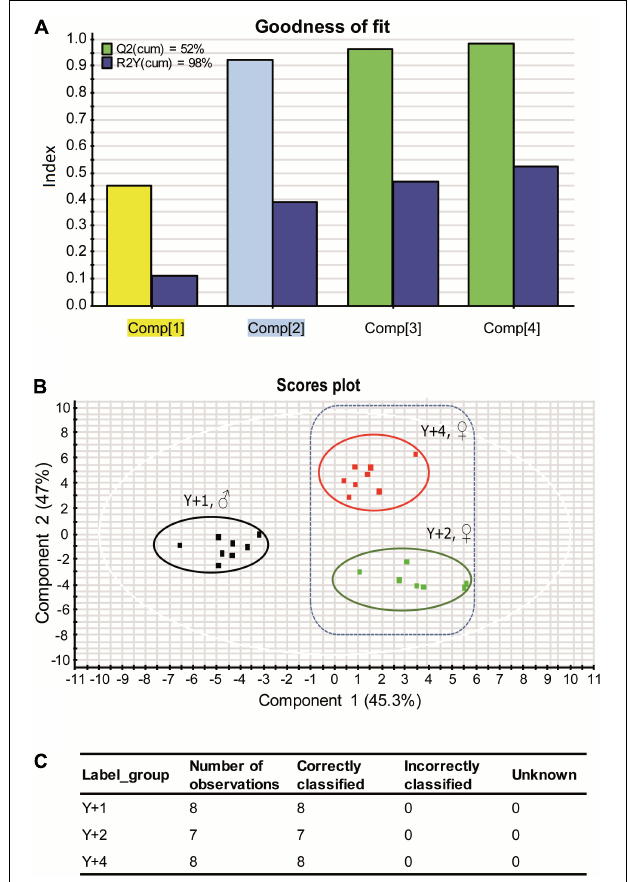
FIGURE 4 | (A) Graphical representation of the goodness-of-fit of the PLS-DA model. Colors of highlighted components in X axis correspond to the colors of the VIP values in Figure 5B . (B) Two-dimensional PLS-DA score plot representing the distribution of the samples between the first two components in the model. (C) Classification summary per group provided by EZinfo v3.0 software showing the suitability of the